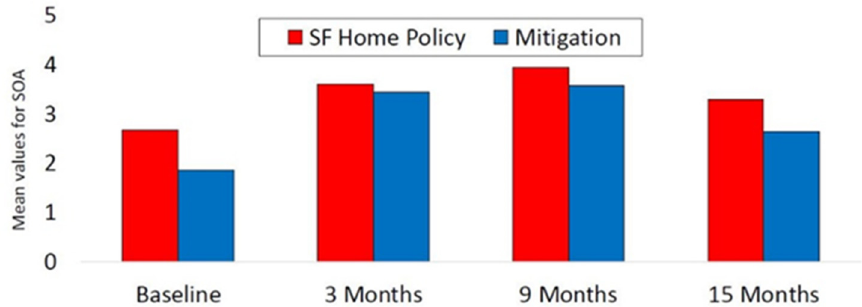
Figure 1. Stage of action among participants with high baseline test values. For the stage of action for the smoke-free home policy mixed model (based on only those with smoker(s) in the home), which included the covariates of age, gender, race/ethnicity, education, family history of lung cancer, and baseline air nicotine risk status, the main effect of time was significant ( F = 12.8, p < 0.001; see Figure 2). Relative to the maximum possible score of 5, the mean stage of action values for the four timepoints were 2.67, 3.59, 3.94, and 3.28, respectively. The post hoc analysis demonstrated that the means for stage of action for the smoke-free home policy at months 3 and 9 were greater than at baseline ( p < 0.001 for both comparisons), and both month 3 and month 9 exceeded month 15 in this outcome ( p < 0.04 for both comparisons). The differences between baseline and month 15 and between months 3 and 9 were not significant ( p > 0.07 for both). Baseline SHS risk status was significant in the model, but none of the demographic covariates were significant. Figure 2. Radon and air nicotine at baseline and 15 months. The repeated-measures model based on the observed log radon values at baseline and 15 months, which included only those with an elevated baseline radon value at or above 4 pCi/L, demonstrated a significant time effect ( p < 0.001; see Figure 2); none of the demographic covariates in the model were significant (see Table 2). The baseline geomet- ric mean was 7.69, compared with a geometric mean of 3.52 at month 15. Of the 54 partic- ipants with high radon who received report back specific to mitigation, 7 (13%) reported at the conclusion of the study (15 months) that they had mitigated. The baseline and 15- month raw radon values (i.e., untransformed) for these 7 homes are shown in Figure 3. There was a reduction in radon levels for all 7 homes post-mitigation, although one 15-